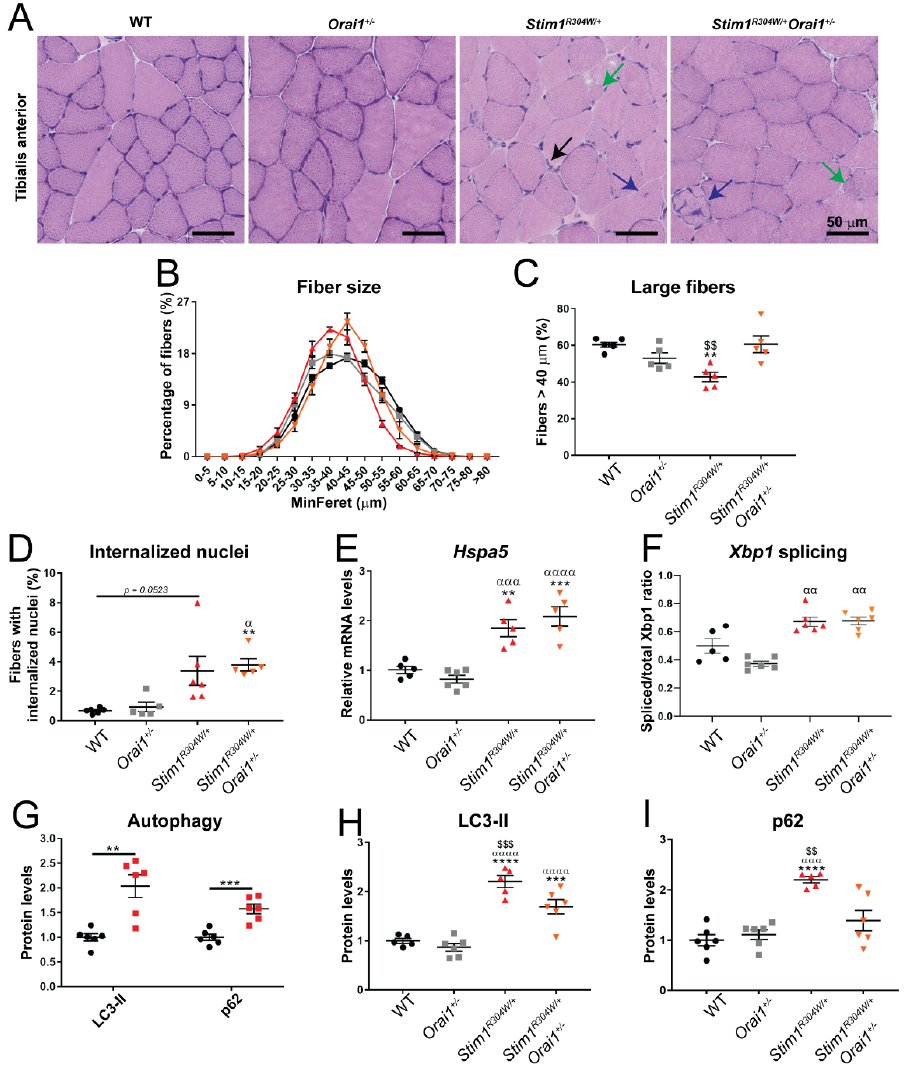
Figure 3. Increased myofiber size and improved autophagy markers in Stim1 R304W/+ Orai1 +/ − mice. ( A ) Representative images of H&E staining on muscle sections from both Stim1 R304W/+ and Stim1 R304W/+ Orai1 +/ − mice at 4 months revealed signs of muscle fiber degeneration such as centralized nuclei (blue arrows), regenerating fibers (green arrow), and immune cell infiltrations (black arrows). ( B , C ) Different fiber size distribution in Stim1 R304W/+ and Stim1 R304W/+ Orai1 +/ − mice and normalization of fibers with a MinFeret diameter of >40 µ m in Stim1 R304W/+ Orai1 +/ − muscle at 4 months (n = 5 mice per group). ( D – F ) Quantification revealed a comparable number of fibers